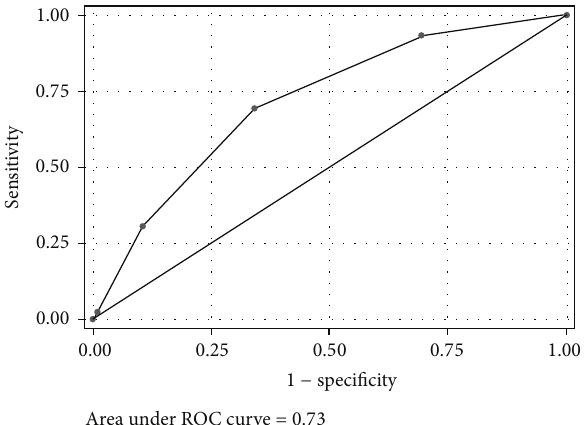
Figure 1: Receiver operating characteristic (ROC) curve of the risk score in predicting undiagnosed type 2 diabetes in the development database. The area under the ROC curve was 0.73 (95% CI: 0.65– 0.78) for the risk